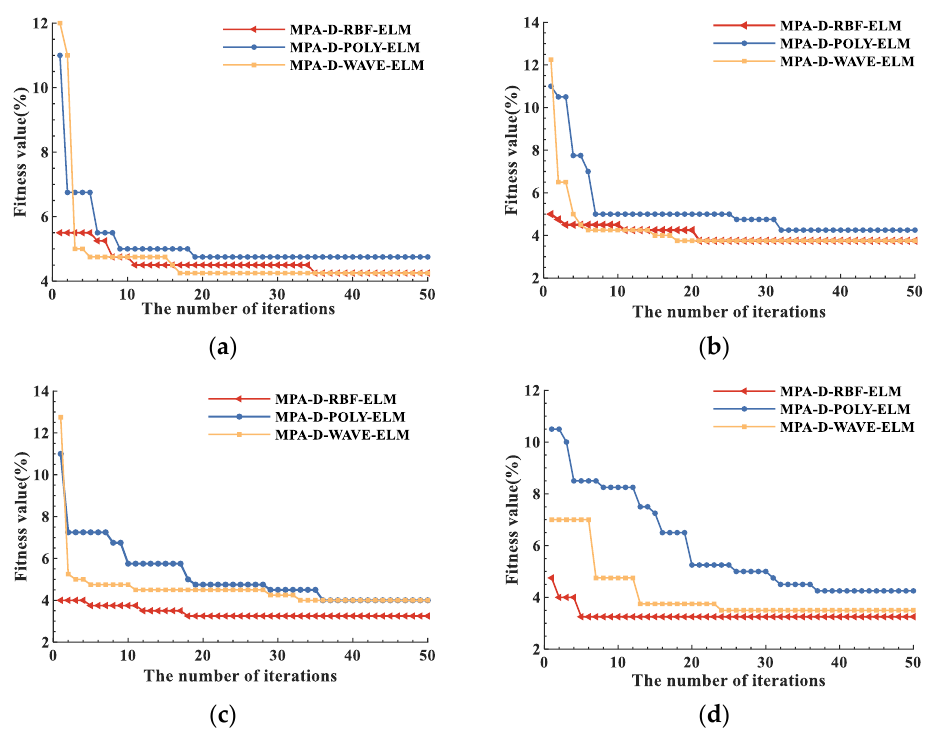
Figure 10. Iteration curves of different DK-ELM optimized by MPA (University of Cincinnati): ( a ) Iteration curves of different DK-ELM optimized by MPA (The model of one layer AE-ELM). ( b ) Iteration curves of different DK-ELM optimized by MPA (The model of two layers AE-ELM). ( c ) Iteration curves of different DK-ELM optimized by MPA (The model of three layers AE-ELM). ( d ) Iteration curves of different DK-ELM optimized by MPA (The model of four layers AE-ELM).